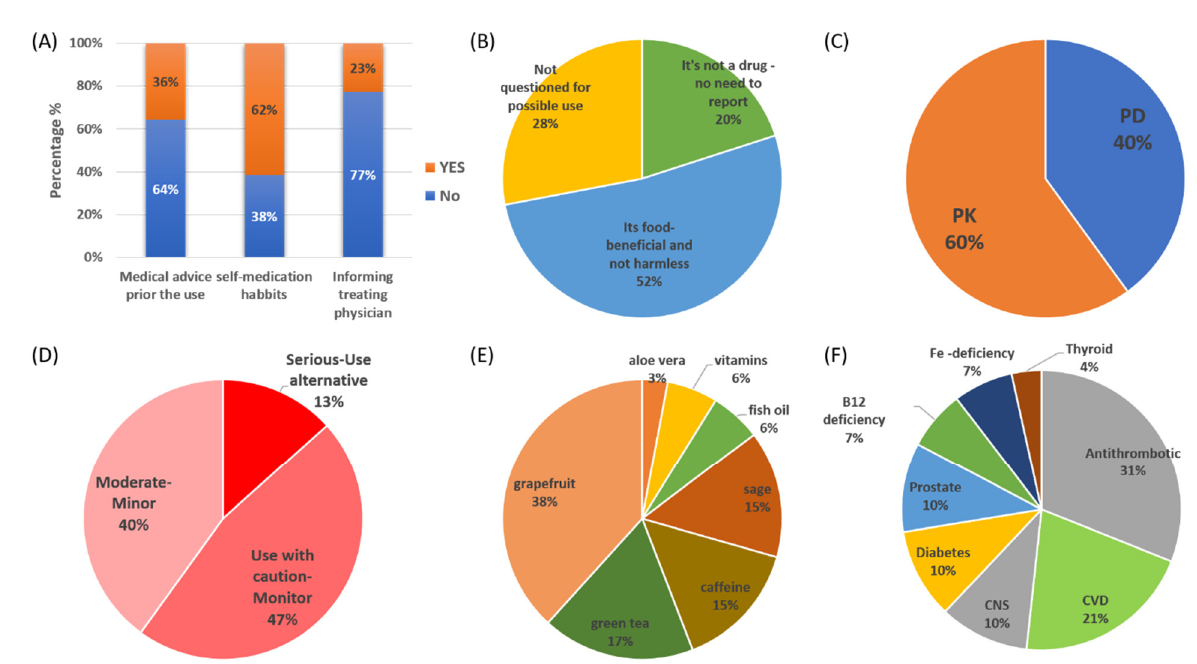
Figure 6. ( A ) Attitudes and ( B ) perceptions regarding the use of DSs from patients in the study. Pharmacological mechanisms ( C ) and clinical significance ( D ) of the identified interactions between prescribed medications and DSs in the study. ( E ) DS categories and ( F ) drug categories identified with potential interactions (CNS: central nervous system; CVD: cardiovascular drugs, including lipid-lowering therapies). Table 4. DDSIs recorded in the study. Clinical significance (Clin. Sign.): 1-Serious–Use alternative, 2-Use with caution- Monitor, and 3-Moderate-Minor. Clin.